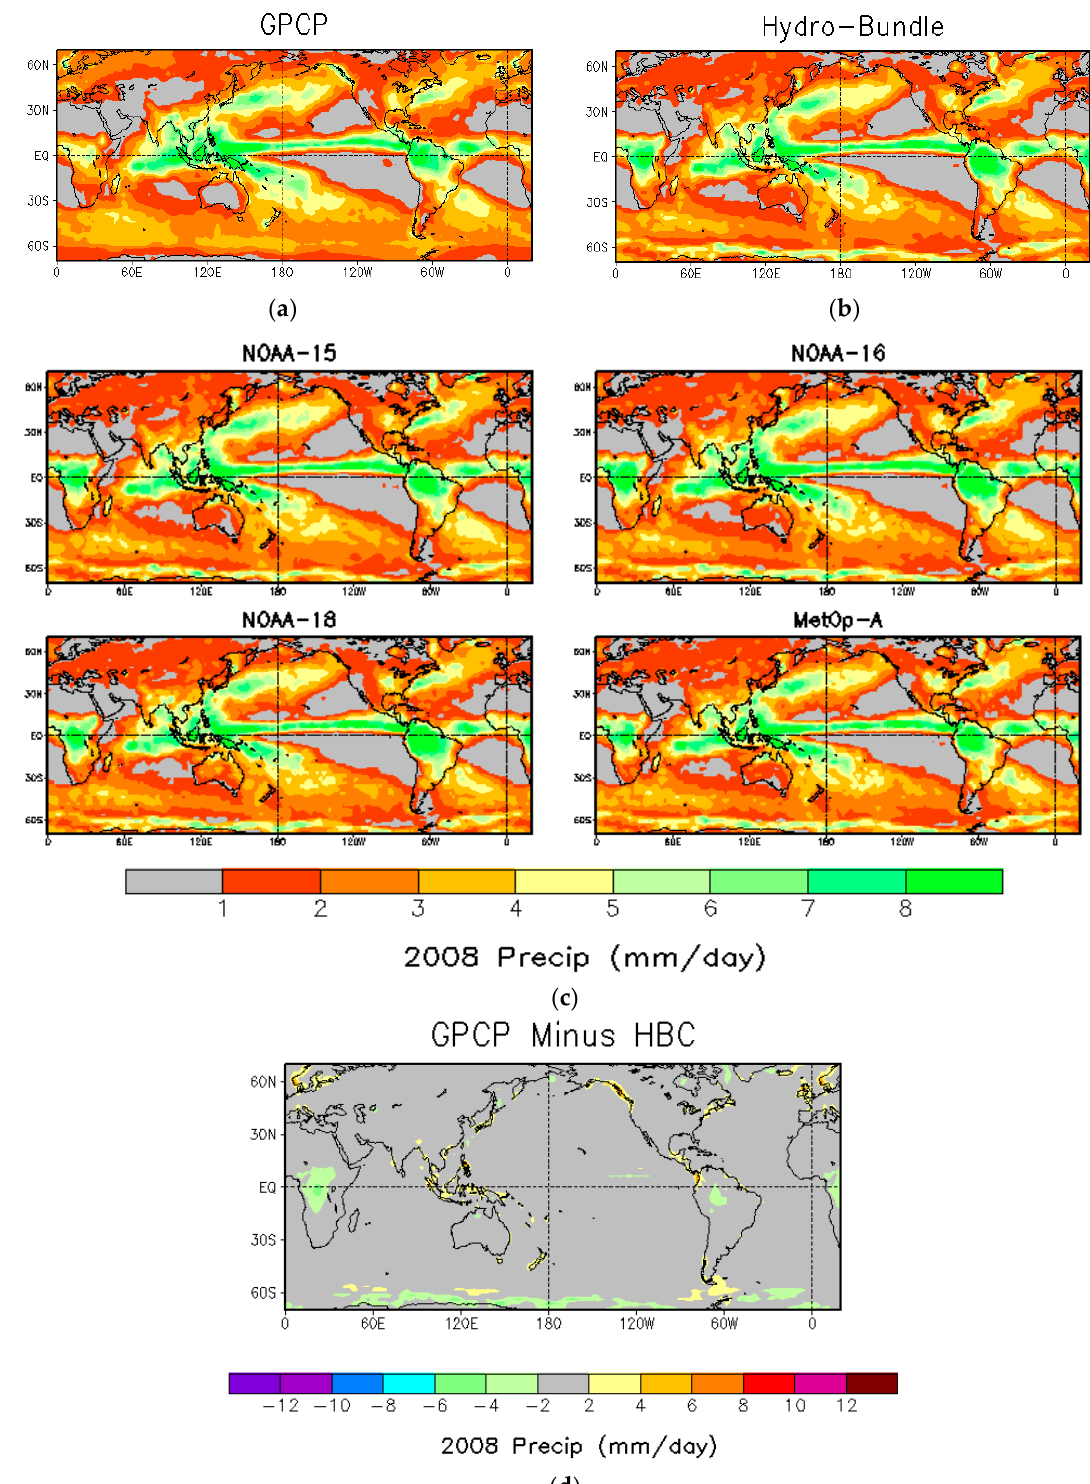
Figure 3. Daily average precipitation for 2008 for ( a ) GPCP, and ( b ) hydrological bundle, and ( c ) daily average precipitation for 2008 for each satellite. GPCP minus HBC (all satellites) is shown in ( d ).